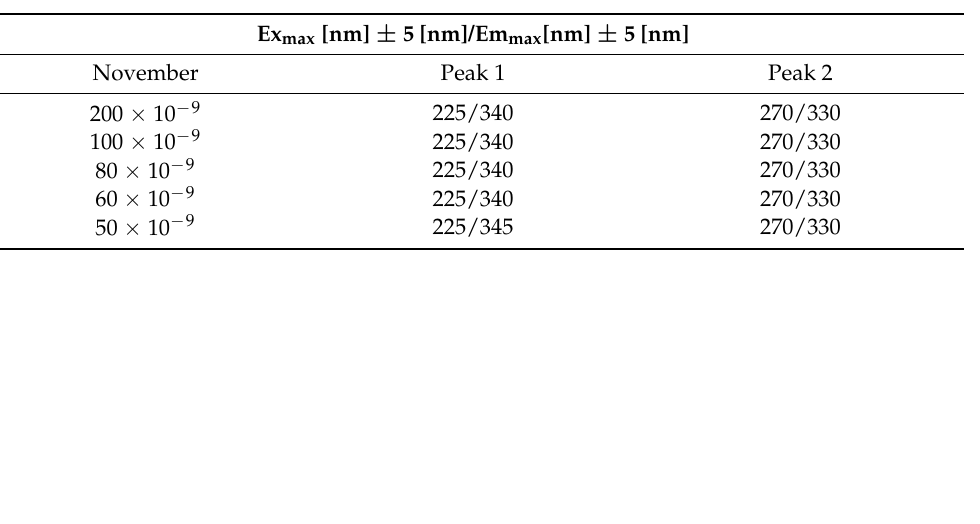
Table 8. Major fluorescent peaks for oil polluted seawater after the fluorescence peaks of natural seawater constituents were removed at various r o/w with their wavelength-independent fluorescent maxima ( λ Ex / λ Em ), for November to March in